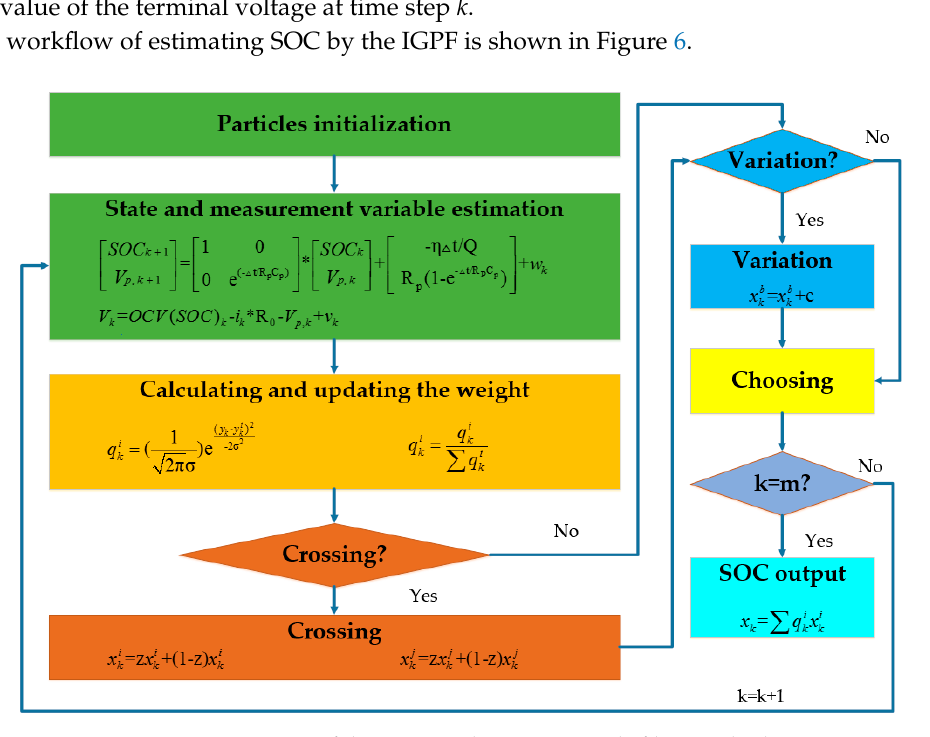
Figure 6. Process of the improved genetic particle filter method.